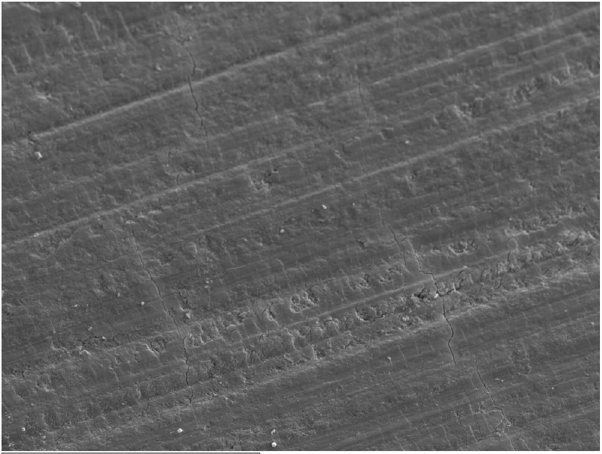
Figure 4. Group 4: Enamel after adhesive removal + DC. SEM micrograph (x1000).